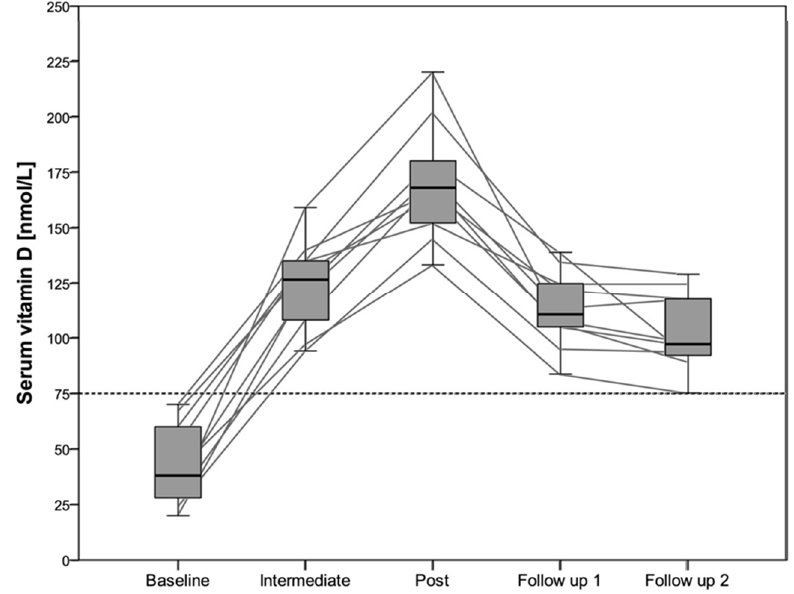
Figure 2. Serum vitamin D concentrations during the intervention and the follow up in 10 participants. Grey lines represents individuals’ data, data presented as median with interquartile range.